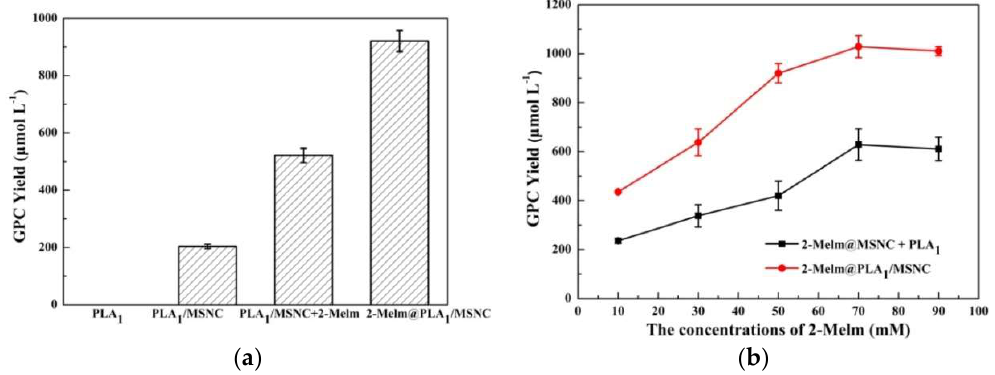
Figure 1. ( a ) Comparison of the yields of L-α-GPC catalyzed by different enzyme samples; ( b ) the effect of 2-Melm concentration in self-assembly of the nanocomposite on the yield of L-α-GPC catalyzed by 2-Melm@PLA 1 /MSNC and the mixture of 2-Melm@MSNC and PLA 1 .